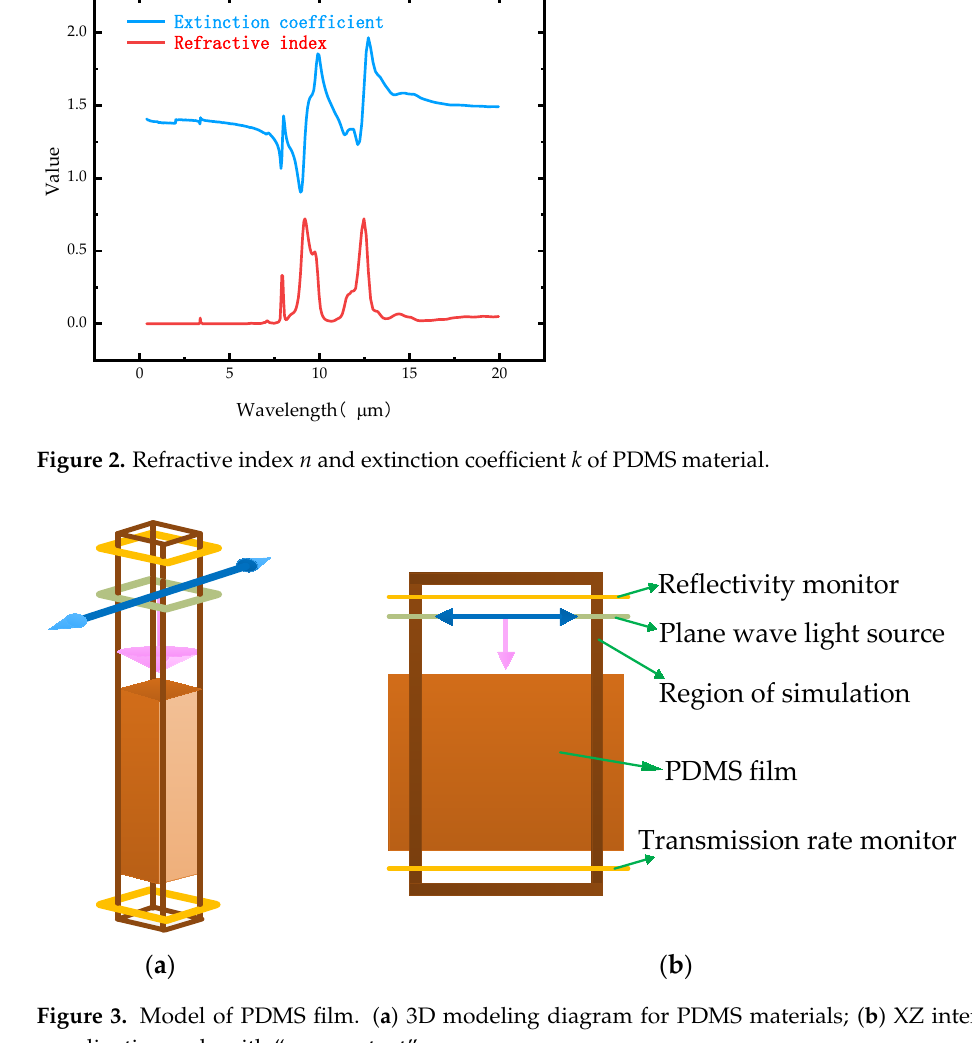
Figure 3. Model of PDMS film. ( a ) 3D modeling diagram for PDMS materials; ( b ) XZ interface coor- dination scale with “zoom extent”.